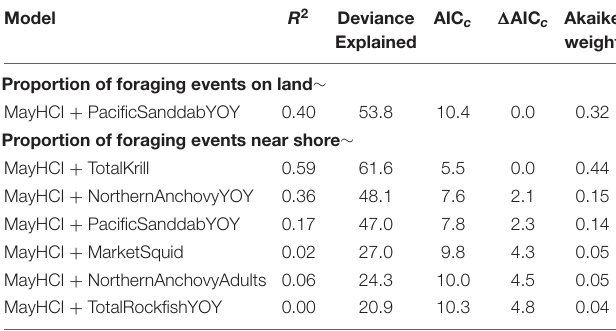
TABLE 2 | Generalized additive models relating the proportion of foraging events on land and near shore to the Habitat Compression Index (HCI) and prey